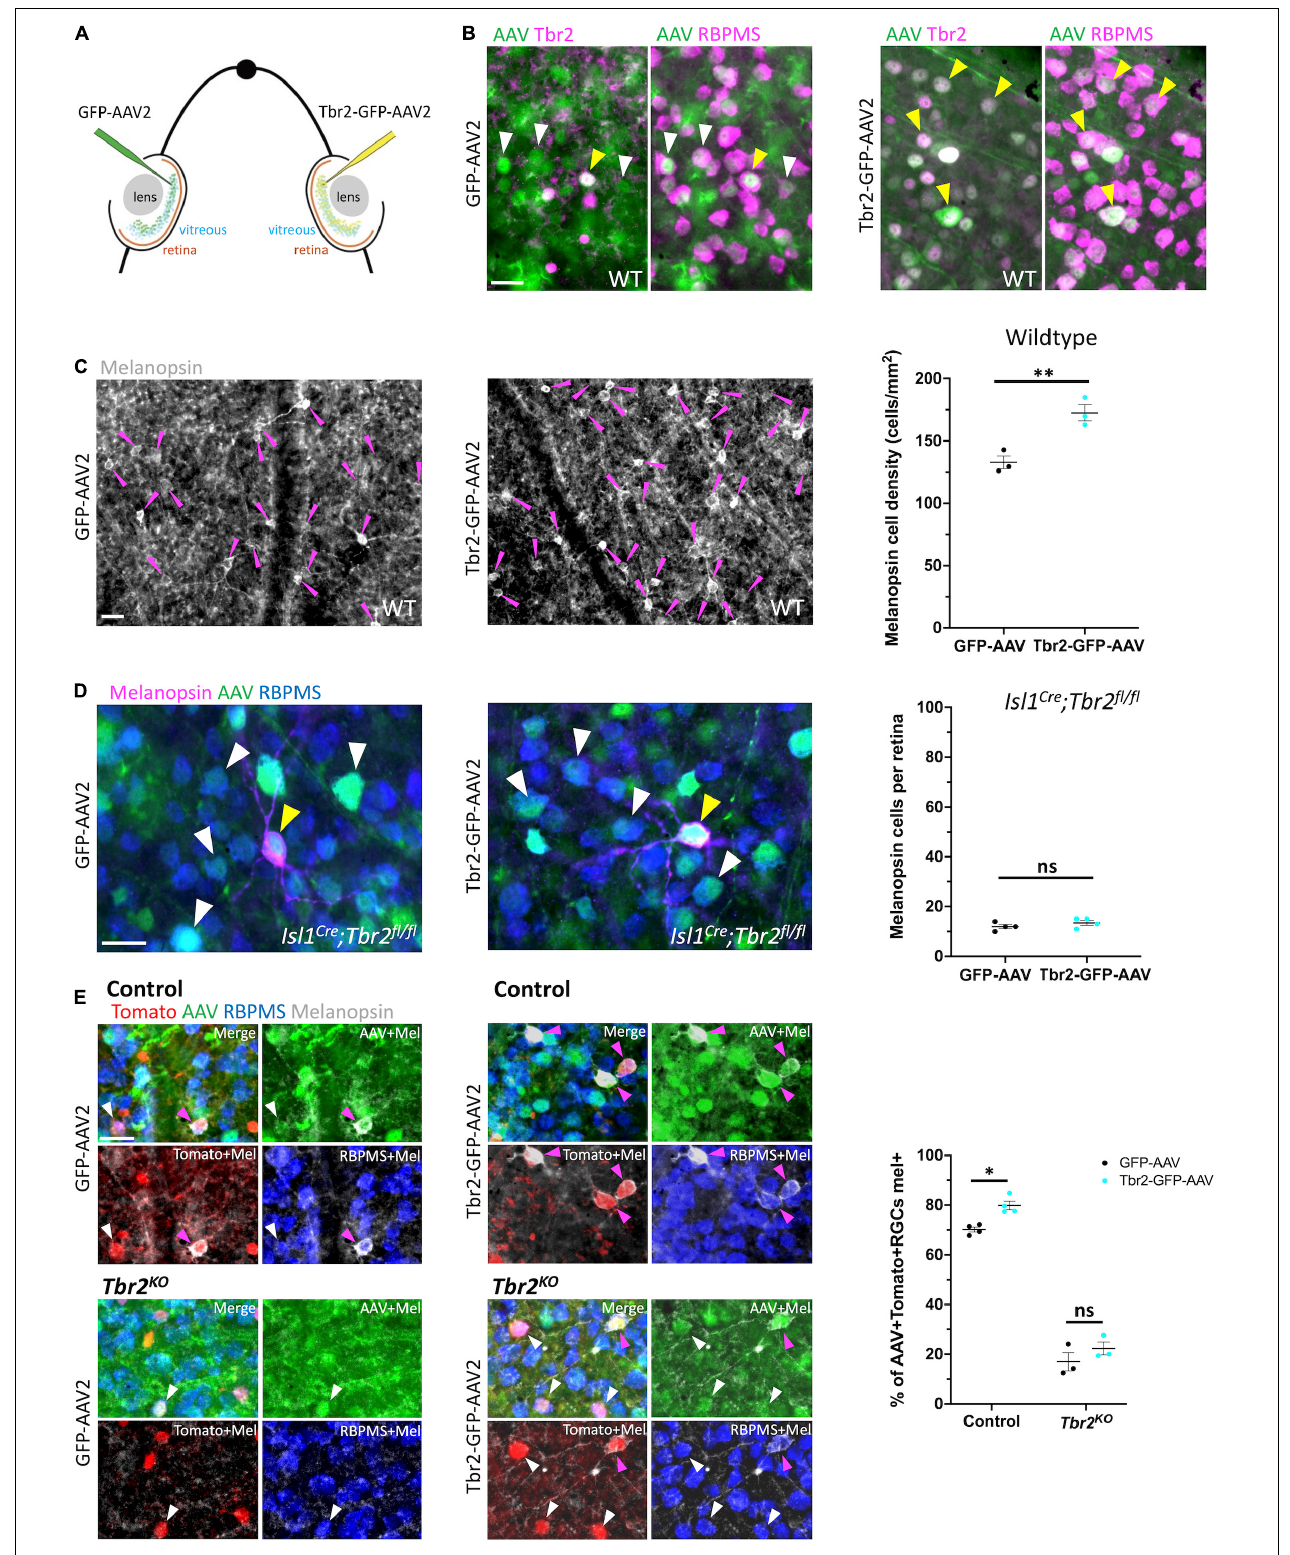
FIGURE 3 | Ectopic expression of Tbr2 does not induce melanopsin expression in non-Tbr2 RGCs. (A) Experimental overview of intravitreal AAV2 injection. One eye